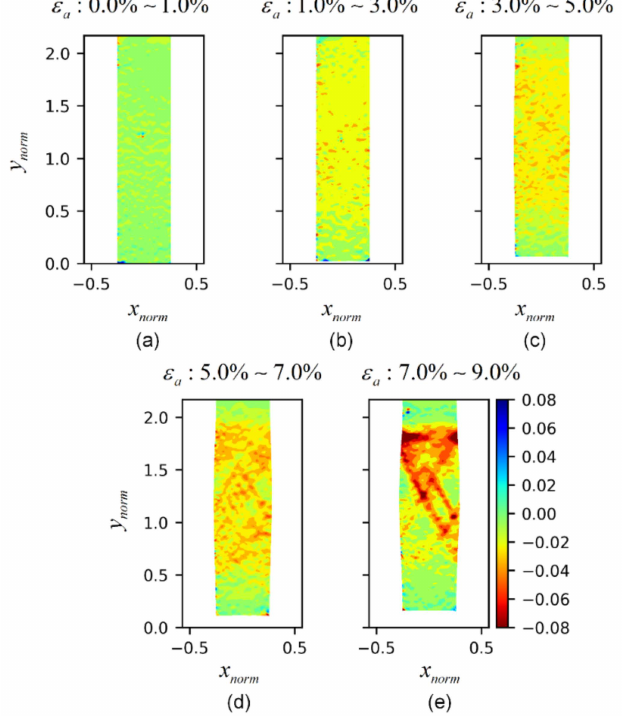
Figure 20. Evolution of grad along ˆ y axis F 33 of test 121304c: ( a ) axial strain 0.0%–1.0%; ( b ) axial strain 1.0%–3.0%; ( c ) axial strain 3.0%–5.0%; ( d ) axial strain 5.0%–7.0%; ( e ) axial strain